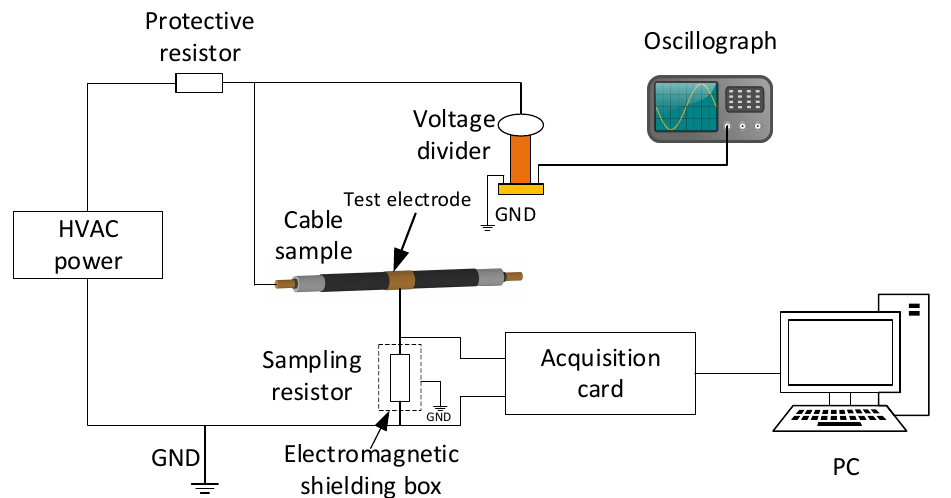
Figure 3. The AC leakage current test experimental setup.